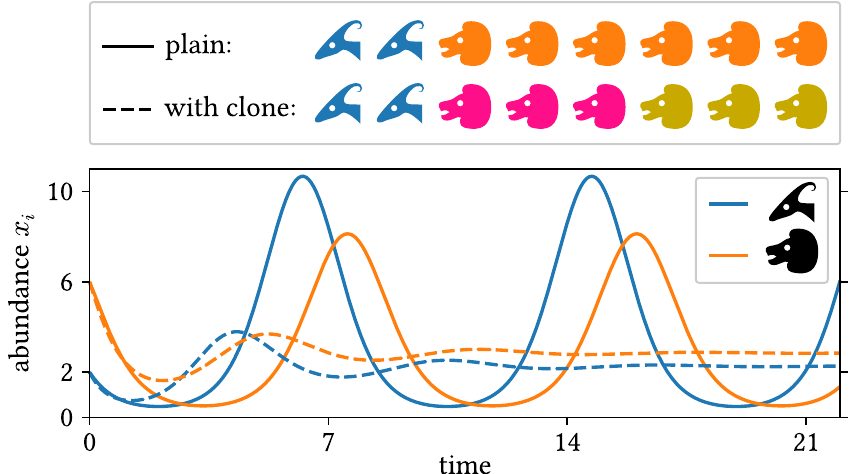
Fig 1. Example of clone inconsistency: Two simulations of a simple predator–prey scenario using the same general model (see text for details). Solid lines: simulation using one population for prey (blue, antelopes) and predators (orange, lions) each. The initial abundances are x 1 (0) = 2 and x 2 (0) = 6 (animal heads in the top legend). Dashed lines: same, but with two identical predator sub-populations (pink and ocher) with half the initial abundance; the abundance shown for the predators is the sum over the two sub-populations. The simulations were run with JiTCODE [51] using the DoPri5 method (S1